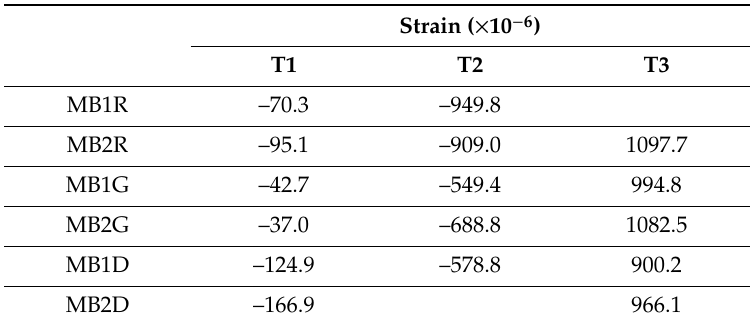
Table 2. The strain of individual samples at the load level of 25 kN.